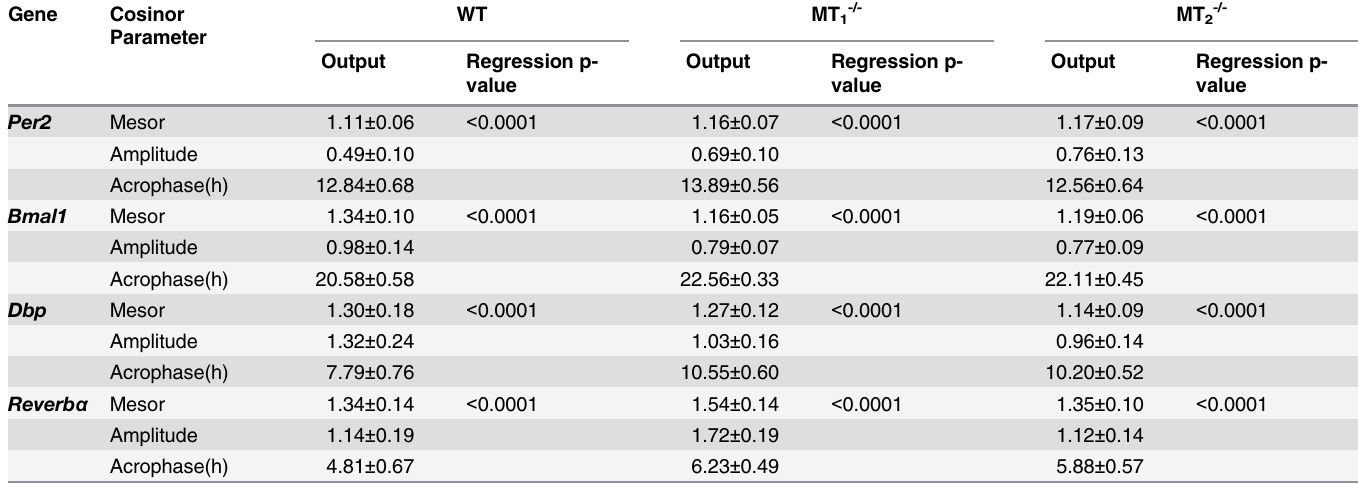
Table 5. COSINOR analysis of clock genes and clock controlled genes within adipose tissue of WT, MT1 -/- and MT2 -/-